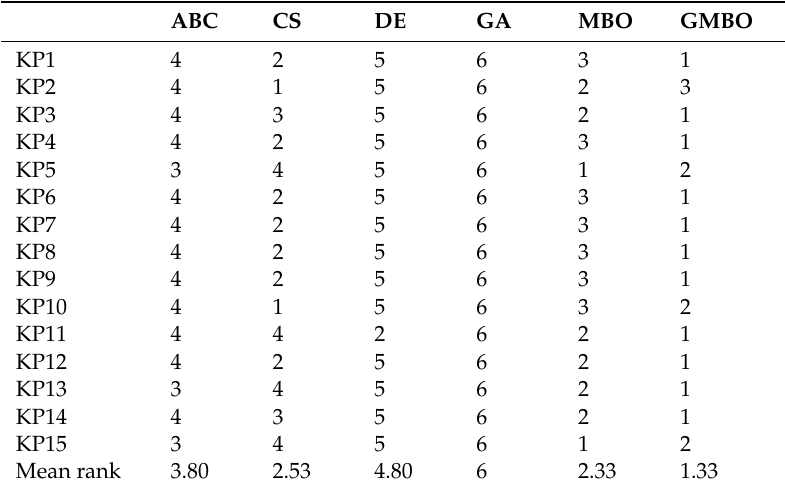
Table 12. Rankings of six algorithms based on the best values.